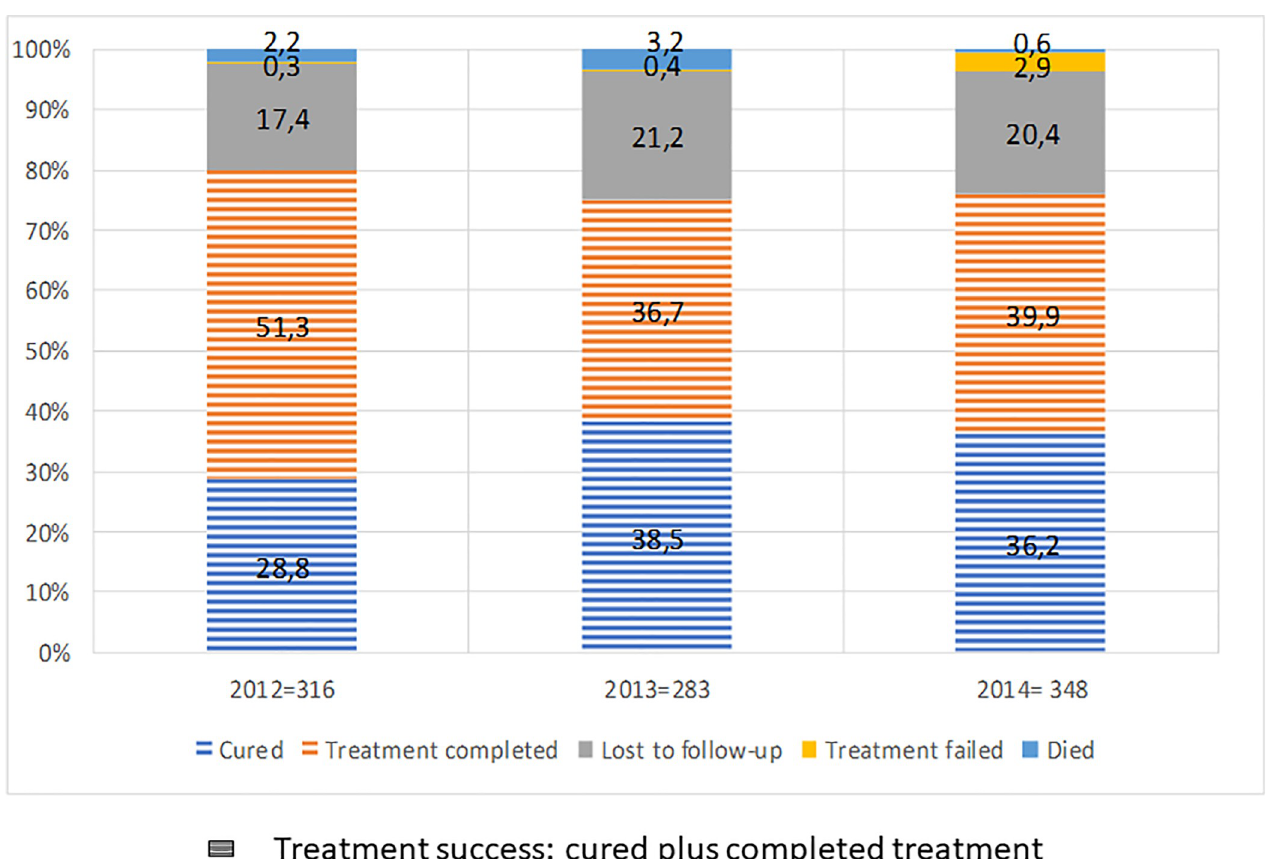
Fig 2. Treatment outcome based on treatment initiation